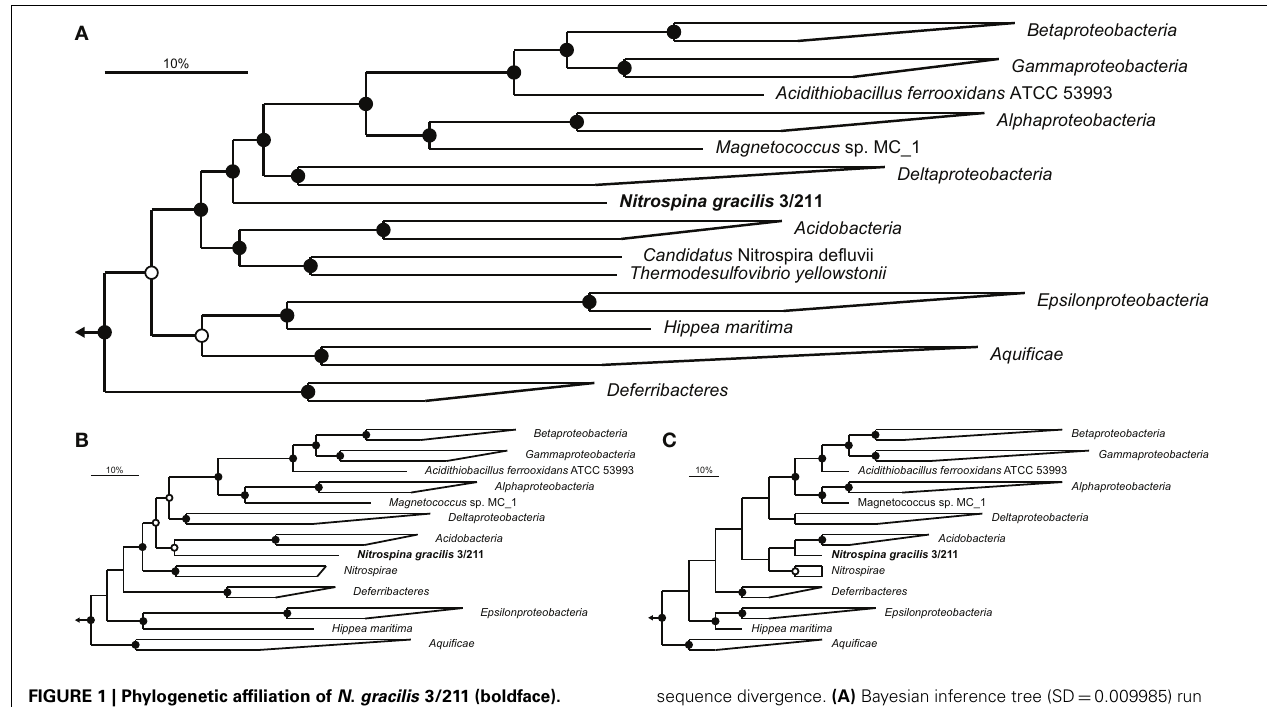
FIGURE 1 | Phylogenetic affiliation of N . gracilis 3/211 (boldface). Trees were calculated using a concatenated dataset of 49 proteins ( TableA1 in Appendix). Members of the phylum Planctomycetes were used as outgroup. Filled and open circles represent statistical support ≥ 90 and > 75%, respectively.The scale bar represents 10% estimated